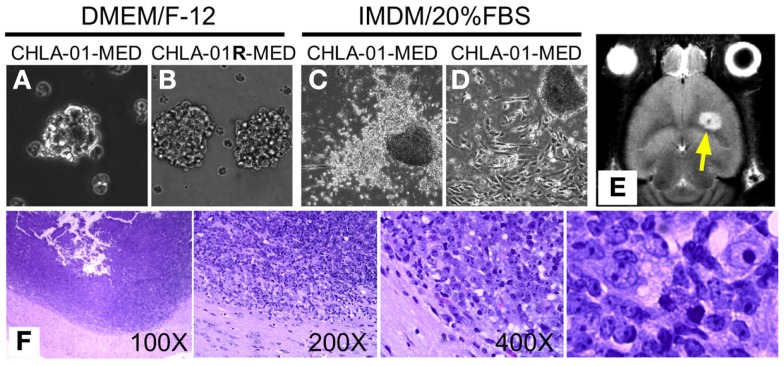
CHLA-01-MED and CHLA-01R-MED medulloblastoma cell lines grow as neurospheres and form intracranial medulloblastoma in vivo. Cell lines shown were generated from the original tumor (CHLA-01-MED) and the pleural effusion recurrence (CHLA-01R-MED). (A,B) The two cell lines grow as neurospheres when cultured under non-adherent serum-free conditions; (C,D) when seeded in FBS-containing medium, low-passage CHLA-01-MED attach and spread. (CHLA-01R-MED do not; not shown); (E,F) low-passage CHLA-01-MED injected into the frontal lobe of NOD/SCID mice developed tumors. (E) MRI of mouse brain with CHLA-01-MED tumor; (F) H&E of a CHLA-01-MED tumor. Right panel is inset from the 400× panel.